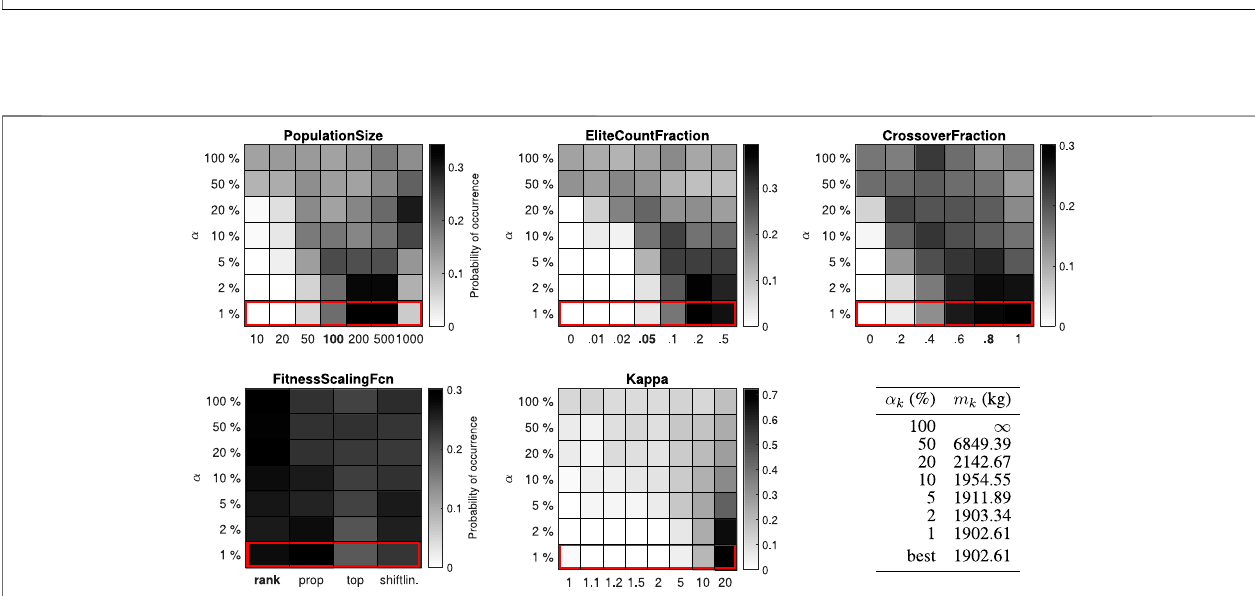
FIGURE 5 | Distribution of control parameter values for the 52-bar truss test problem (12 design variables).